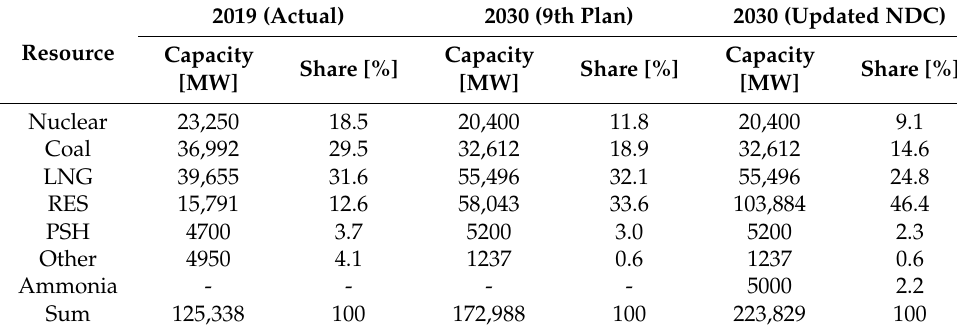
Table 2. Assumed installed capacity mix in the Korean power system.